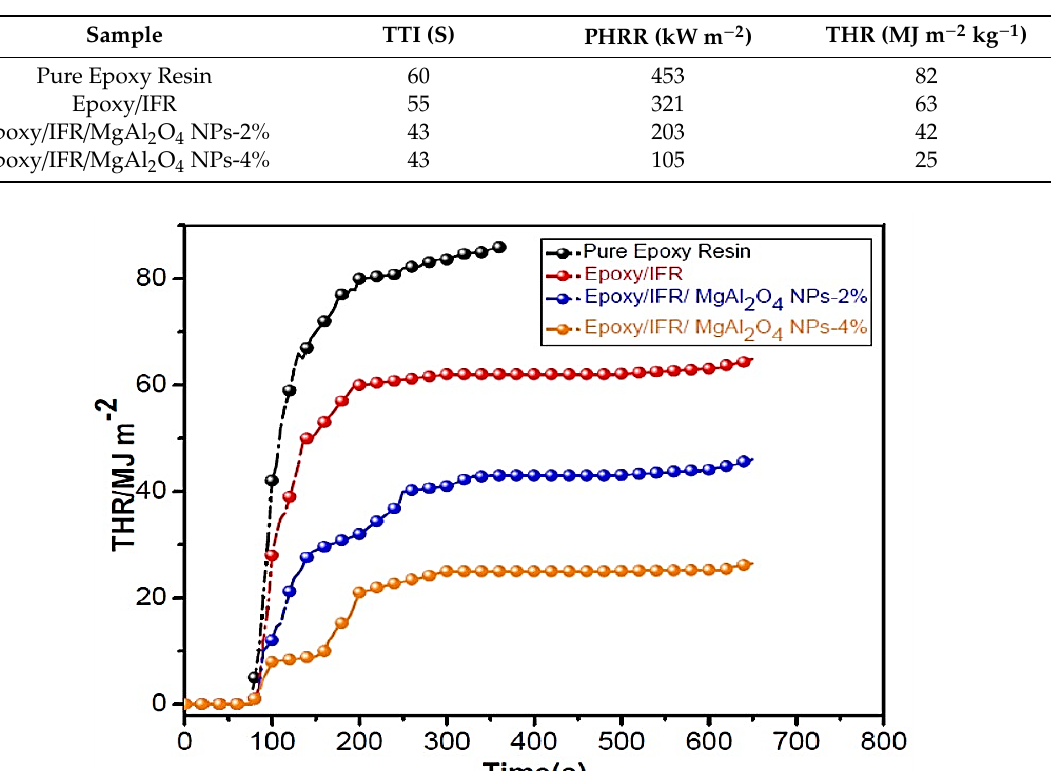
Table 4. Cone calorimeter results of the coatings.